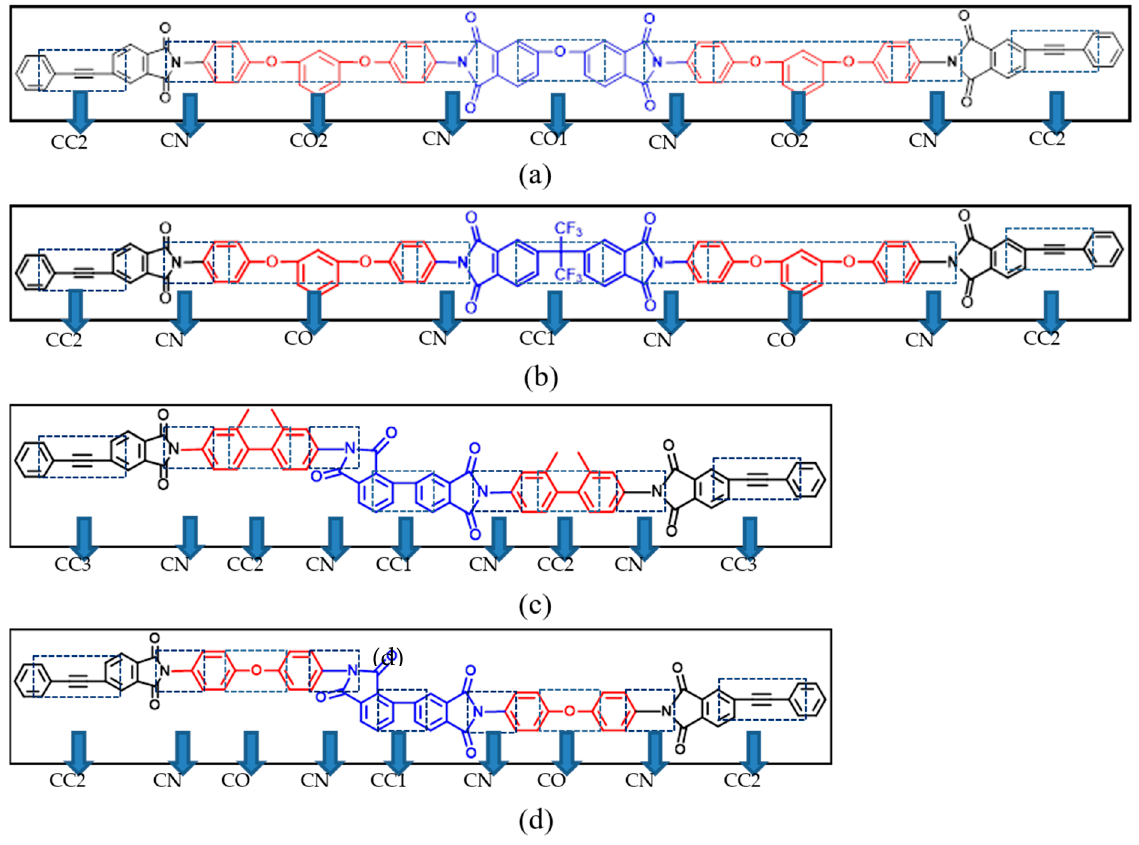
Figure 7. Division of dihedral angle: ( a ) ODPA-APB; ( b ) 6FDA-APB; ( c ) α -BPDA-DMBZ; and ( d ) α -BPDA-4,4-ODA.